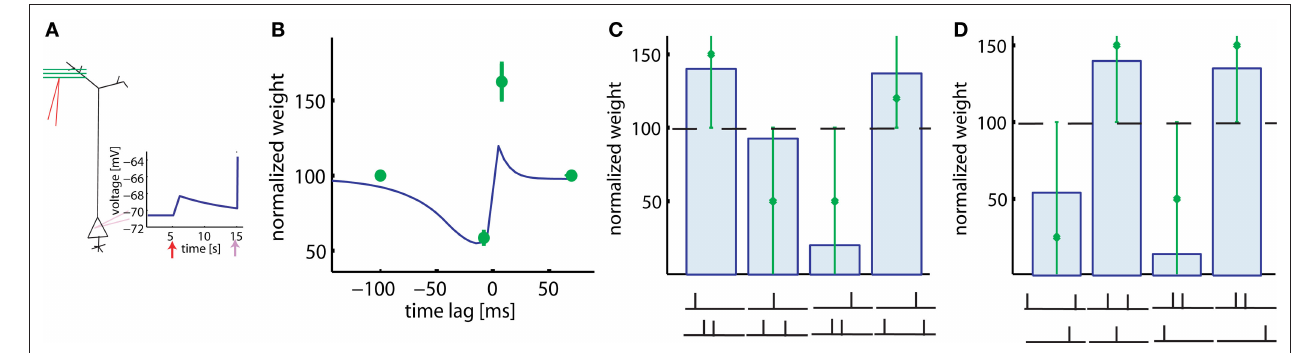
FigurE 5 | results with extracellular stimulation. (A) Extracellular stimulation of presynaptic fibers followed 10 ms later by postsynaptic stimulation is described by a compound EPSP of 2.5 mV and the upswing of an action potential (schematic). (B) 60 repetitions of pre-post pairs lead to LTP despite a repetition frequency of only 0.2 Hz. The amount of LTP in our model (blue line) is smaller than in the corresponding experiment (green). The reverse firing leads to LTD.